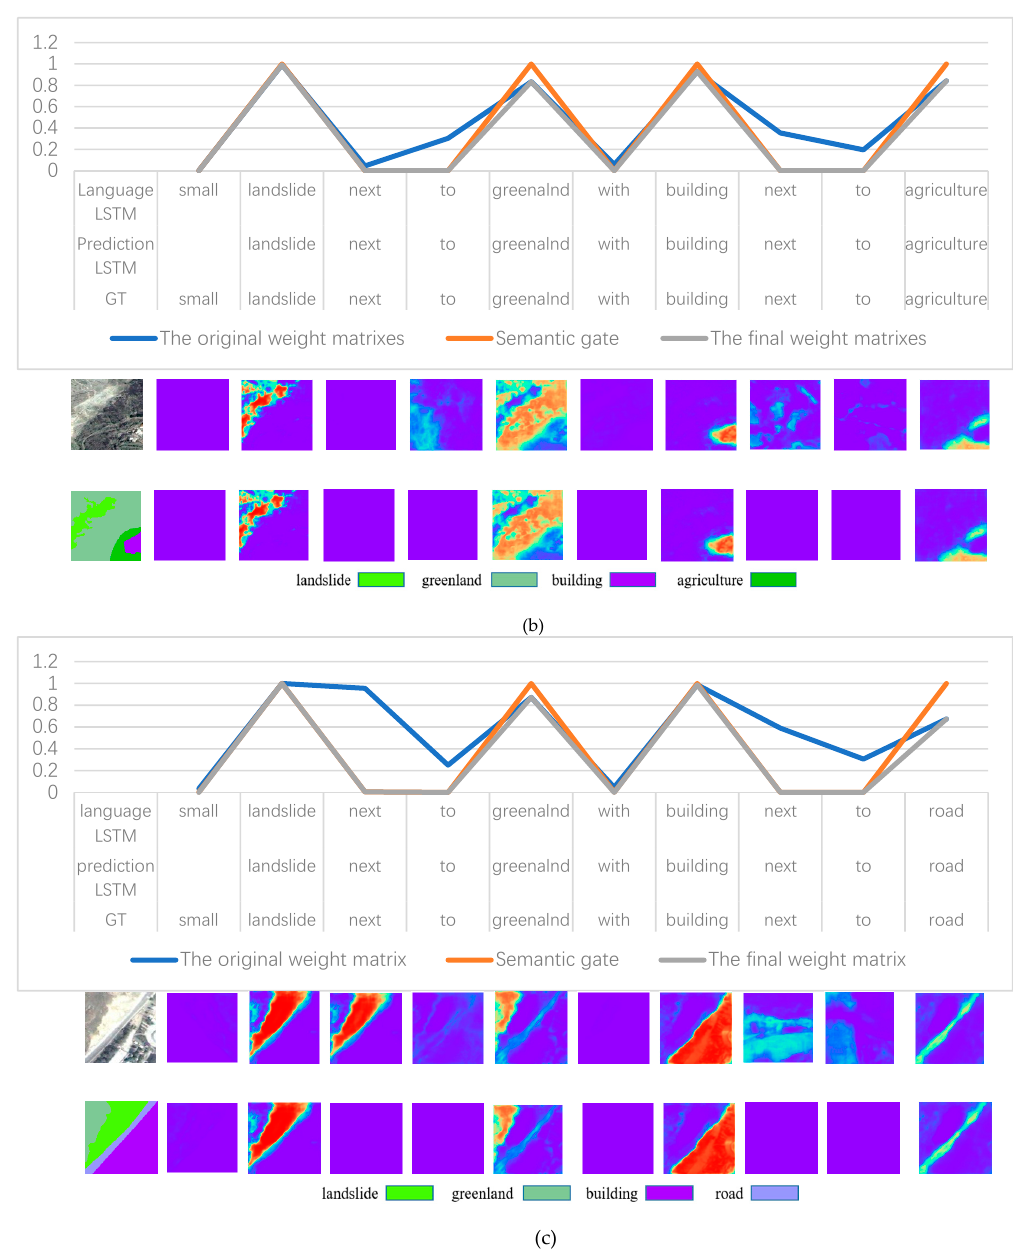
Figure 19. The control effect of the semantic gate.